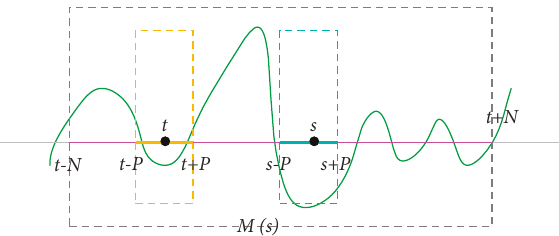
Figure 1: The relationship between the parameters of the NLM